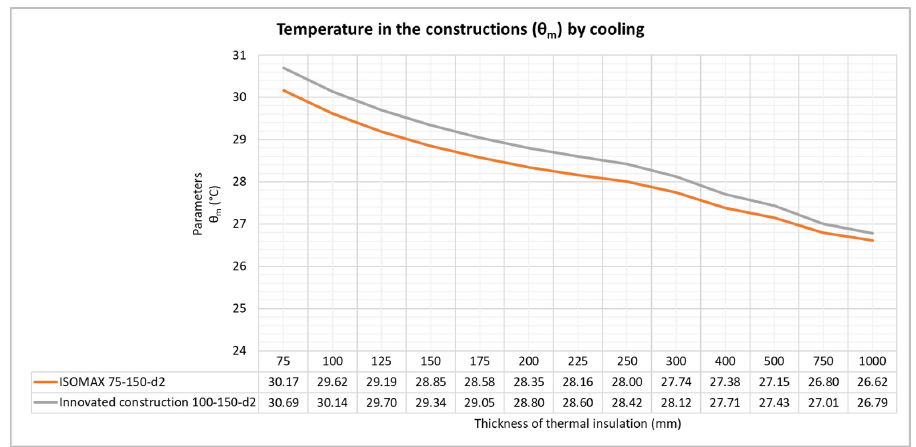
Figure 24. Dependence of the average temperature θ m in the thermal barrier layer of the ISOMAX panel and the innovative panel during the cooling period on the thickness of the external thermal insulation.